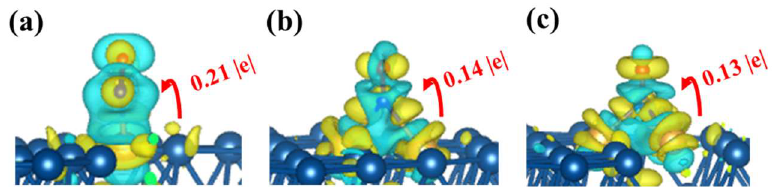
Figure 4. Charge density difference of the NO intermediates for ( a ) Au single /Pt(111), ( b ) Au dimer /Pt(111), and ( c ) Au trimer /Pt(111). Isosurface level is 0.0012 e/Å 3 .